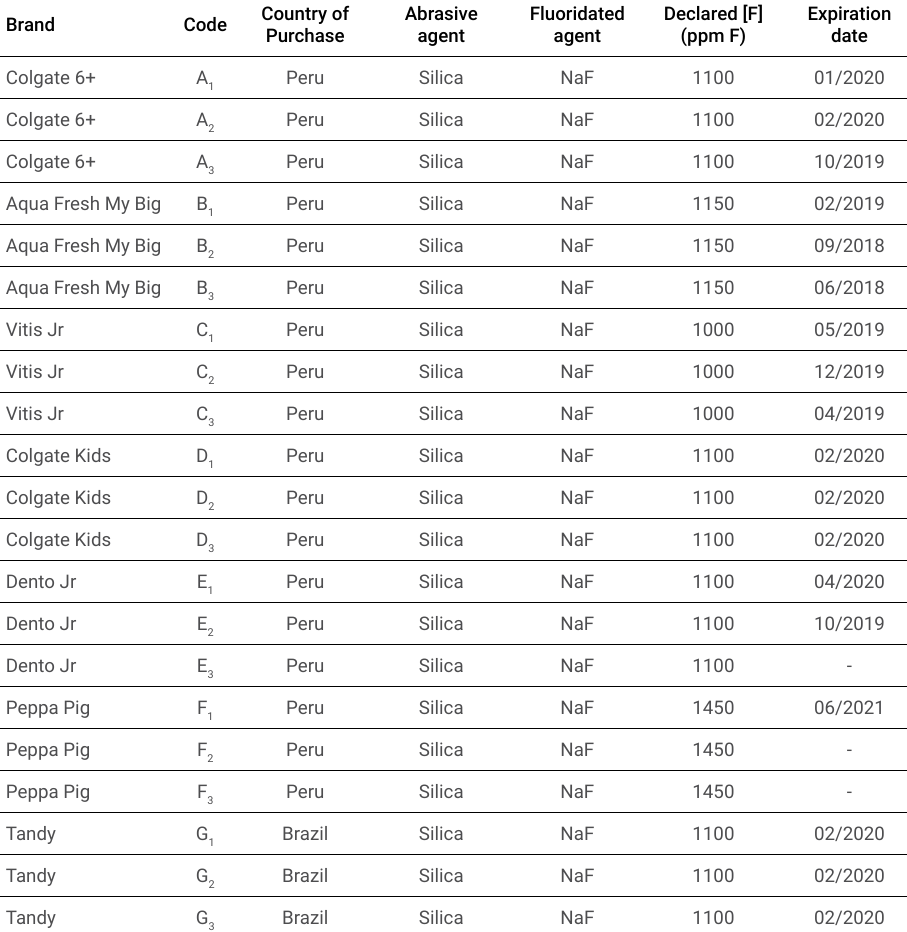
Table 1. Information on the toothpastes analyzed